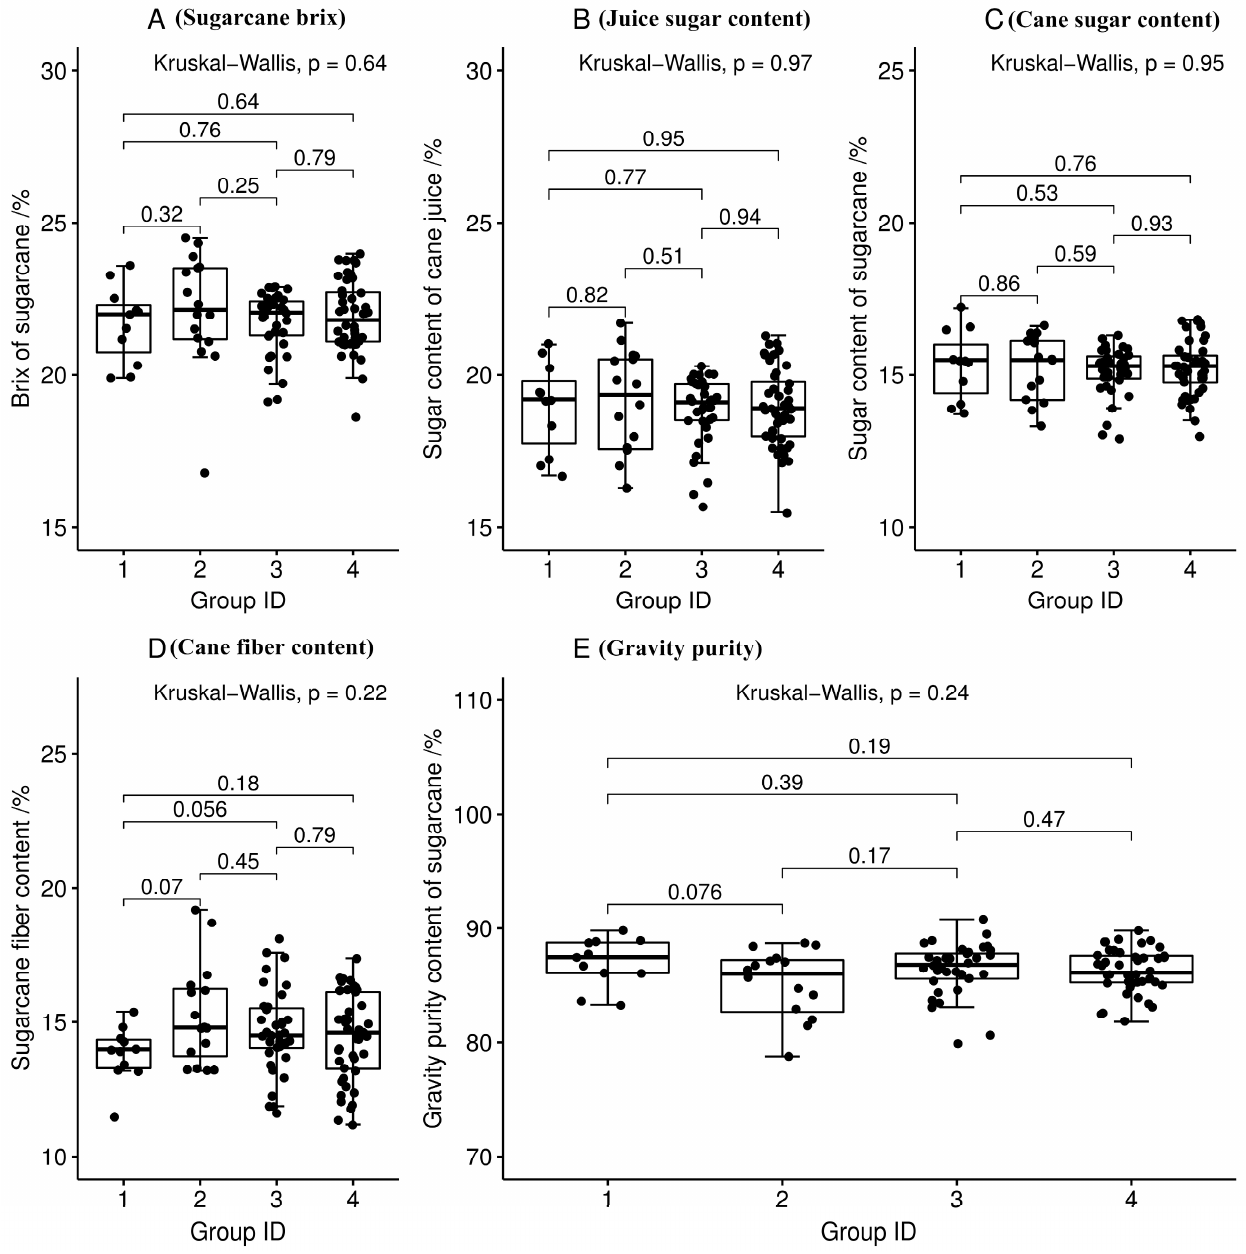
Figure 3. Differences in industrial characteristics between the four cluster groups. Comparisons of ( A ) sugarcane brix, ( B ) juice sugar content, ( C ) cane sugar content, ( D ) cane fiber content, and ( E ) gravity purity are shown. R statistics Kruskal–Wallis test was used for the difference analysis.